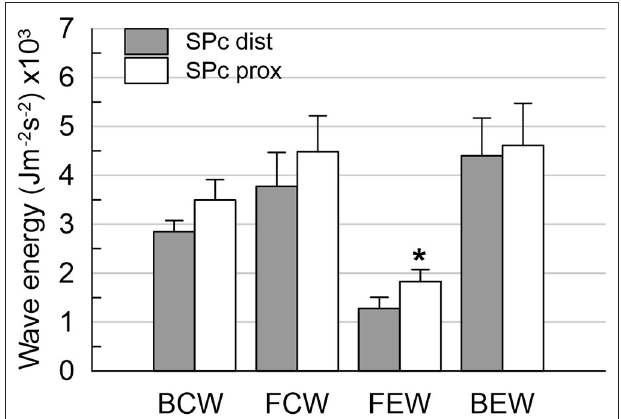
FIGURE 3 | Wave energies downstream of the stenosis obtained from wave intensity profiles separated with local SPc assessed at proximal and distal location. Using distal SPc tends to lower the derived wave intensity. * p < 0.05 compared with distal wave energy.